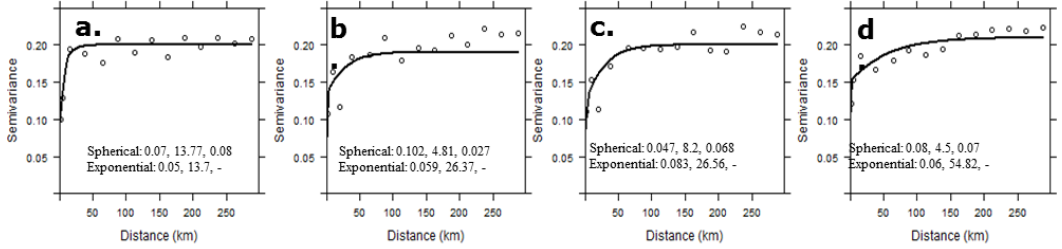
Semivariograms and fitted models for spatial correspondence of the Globcover ( a ); LC-CCI ( b ); MODIS ( c ); and Globeland30 ( d ) maps (model parameters: partial sills, range and nugget).